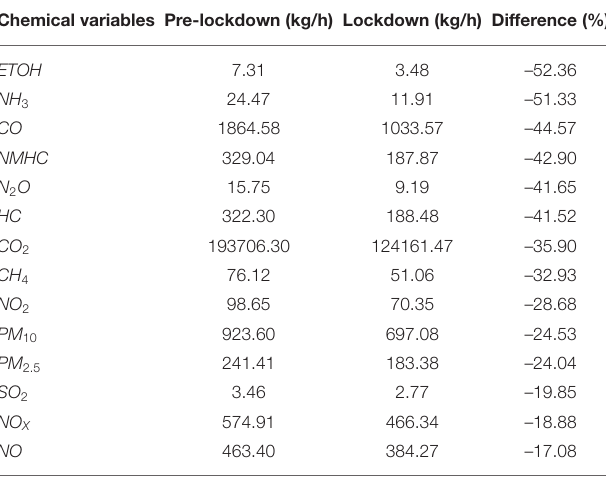
TABLE 2 | Average hourly emissions (kg/h) by the period in